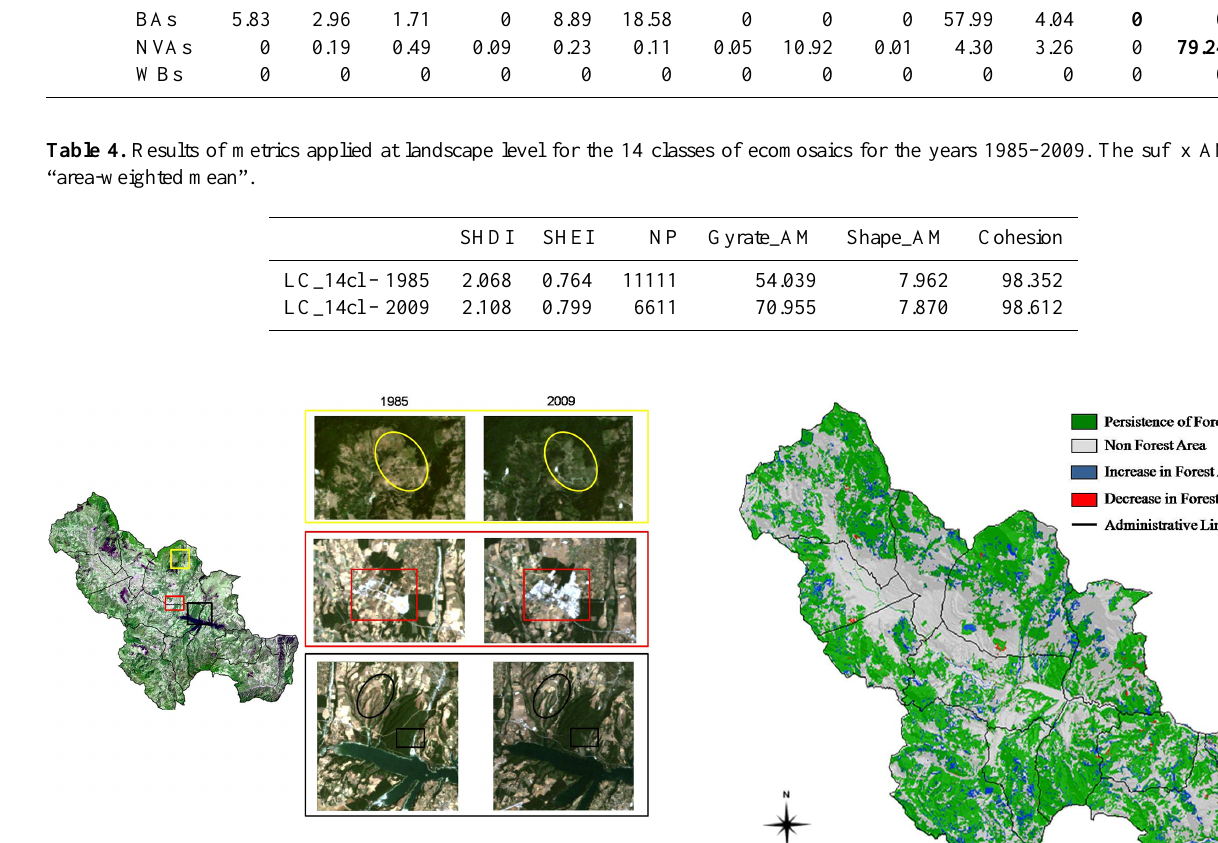
Figure 3. Example of changes occurred in the high Agri Valley in the period 1985–2009. Areas highlighted on the map on the left are zoomed in on the right by a Landsat 5-TM RGB composition (R – band 3; G – band 2; B – band 1). In the yellow square an oil well and the service road with a wide herbaceous structure; in the red square the Viggiano industrial area where the Centro Olio Val d’Agri (COVA) is located; in the black square woodland variations close to Pertusillo Lake and new service roads.